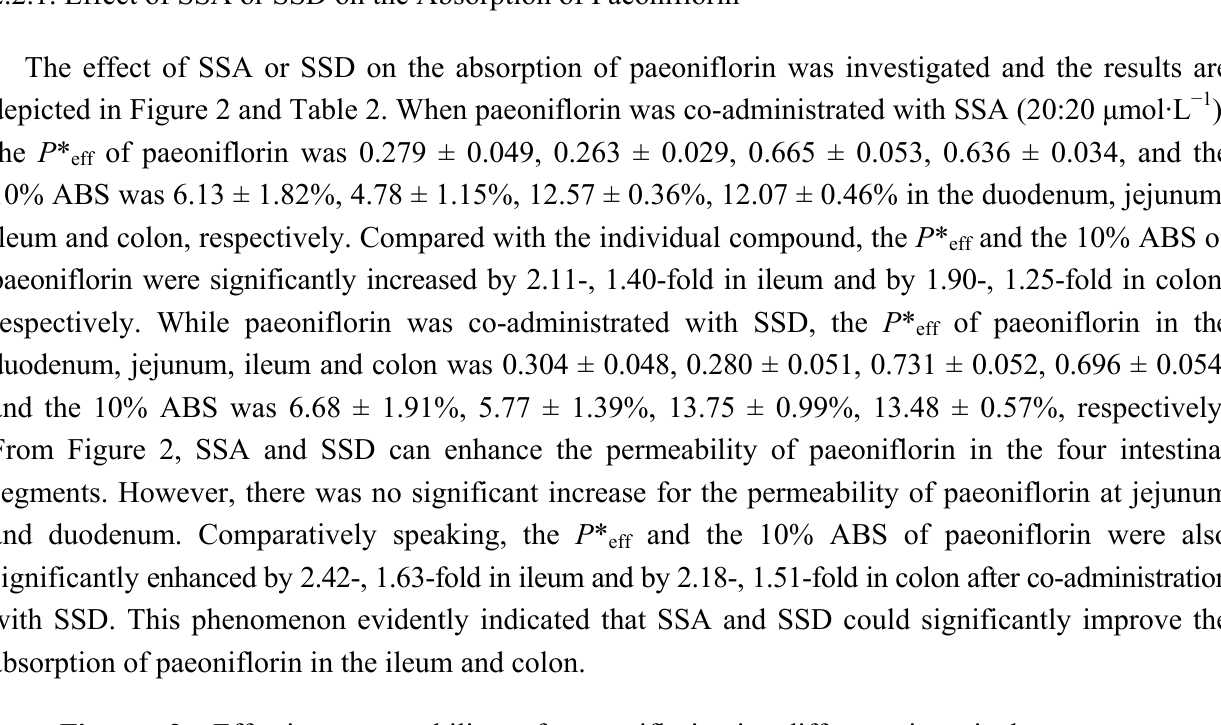
Figure 2. Effective permeability of paeoniflorin in different intestinal segments. ( a ) paeoniflorin alone; ( b ) paeoniflorin co-administration with SSA; ( c ) paeoniflorin co-administration with SSD. P < 0.05 vs . paeoniflorin